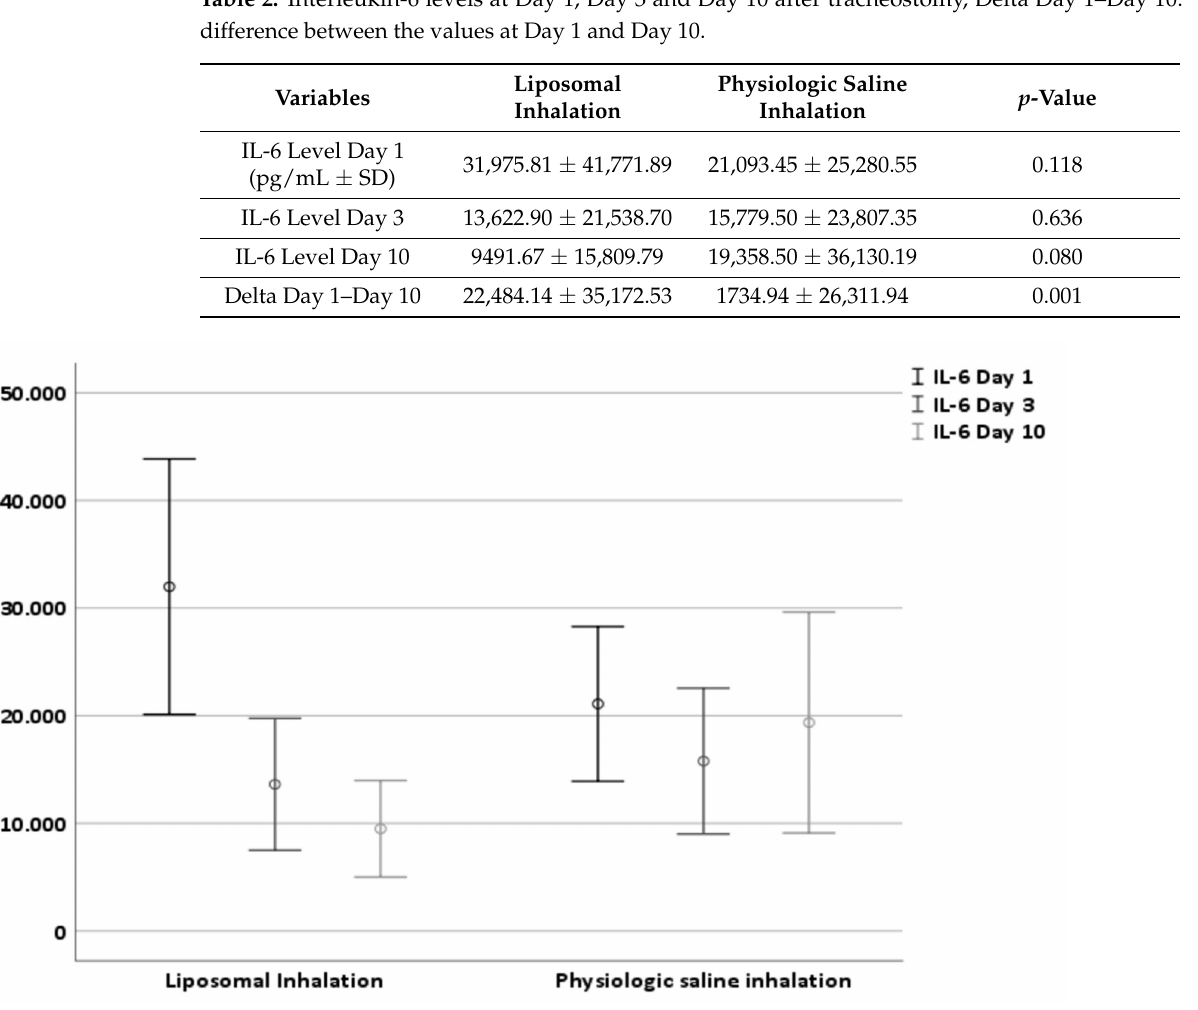
Figure 3. Effect of liposomal and physiologic saline solution inhalation on tracheal IL-6 level at day 1, day 3 and day 10 after